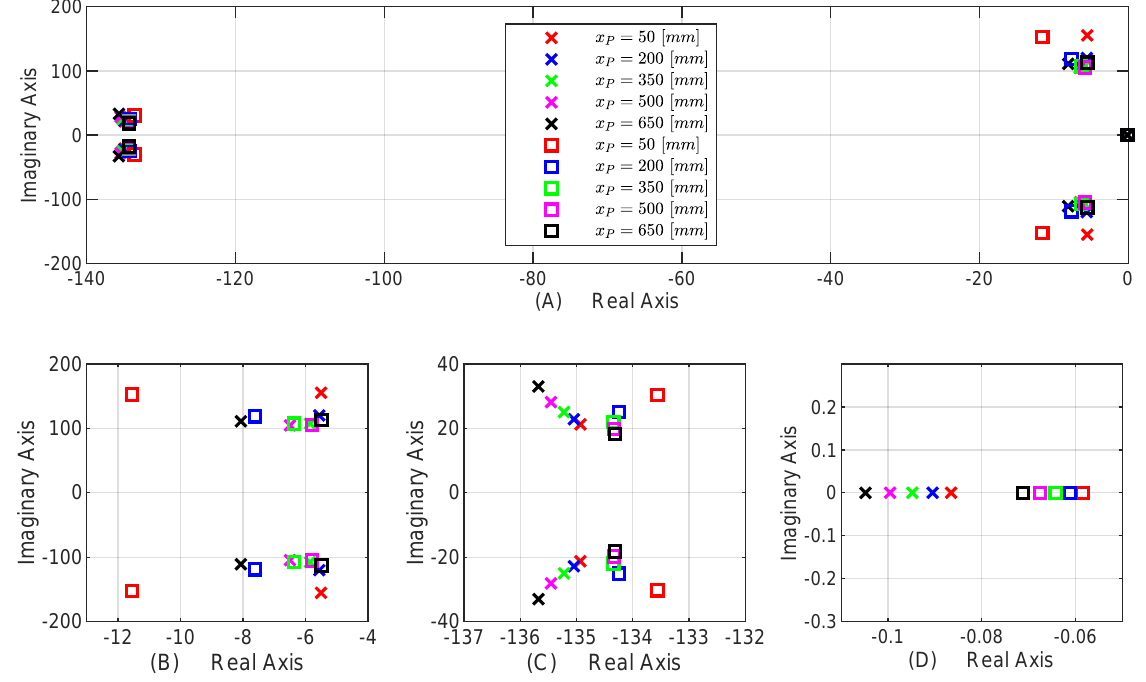
Figure 8. ( A ) Pole maps as functions of the piston position. ( B , C ) depict the two complex conjugate pole pairs, and figure ( D ) depicts the real pole. Crosses denote poles in Q1 and Q2 (and Q1-2), and squares denote poles in Q4 and Q3 (and